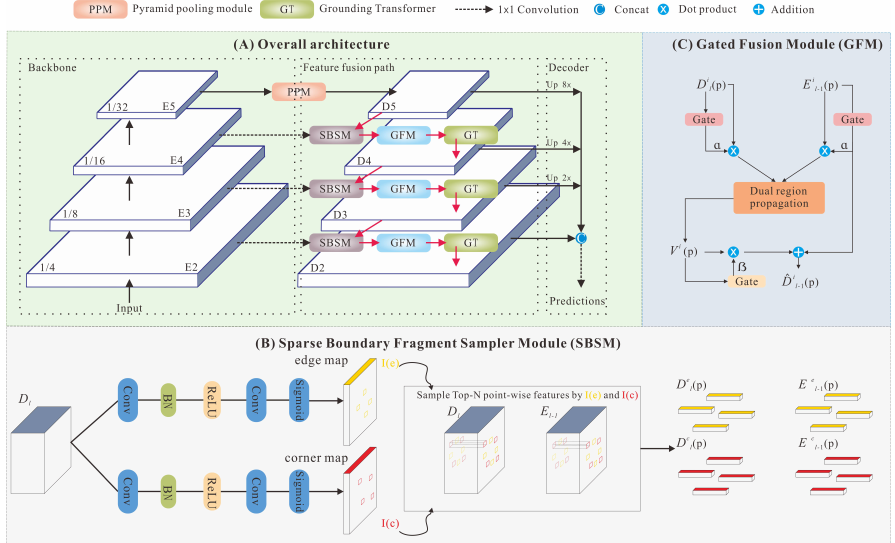
Figure 4. Frameworks of the proposed SGFANet. ( A ) The overall pipeline of the proposed SGFANet includes a bottom-up basic hierarchical feature extractor, a top-down feature fusion path composed of SBSM, GFM, and GT, and a decoder. ( B ) The sparse boundary fragment sampler module (SBSM) serves to sample the top- N representative feature points about the building boundaries (i.e., the edges and corners). N is a hyperparameter and can be different for edges and corners. ( C ) The gated fusion module (GFM), which is used to calculate the affinity of the selected point-wise